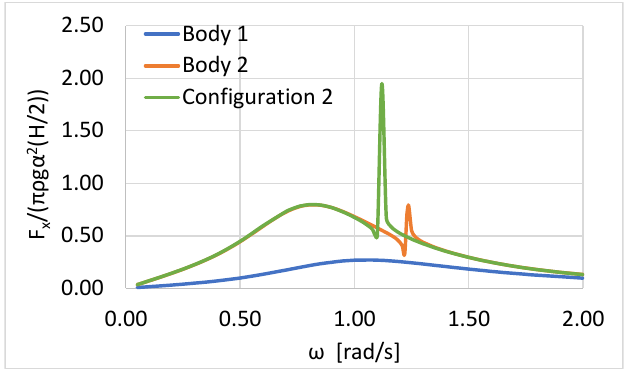
Figure 7. Horizontal exciting forces on the Configuration 2. The results are also compared with the corresponding forces on the isolated Bodies 1 and 2.